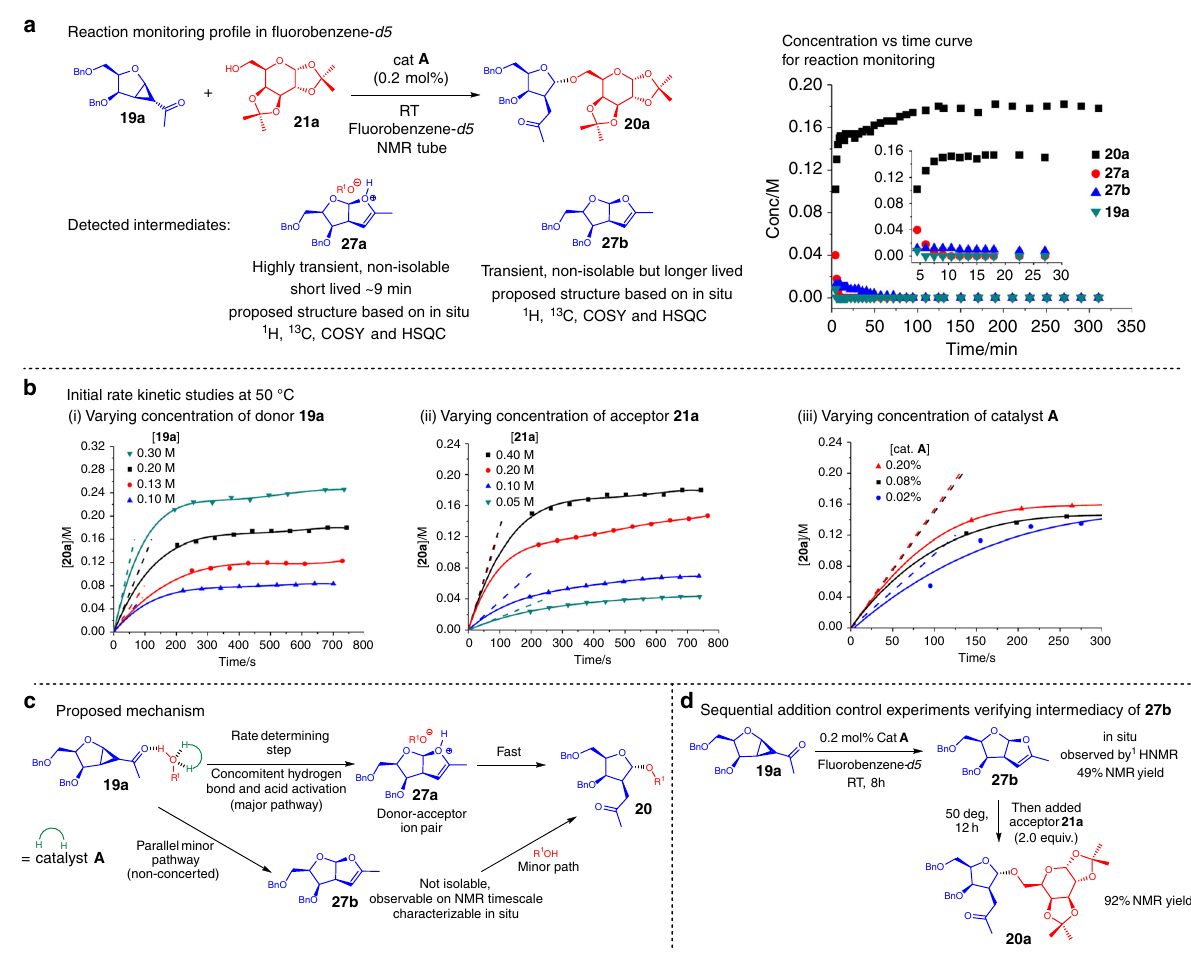
Fig. 2 Mechanistic and kinetic studies. a In-situ NMR monitoring of strain-release furanosylation of 19a at RT. b Initial rate kinetic studies of strain-release furanosylation. c Proposed mechanistic model of the strain-release furanosylation. d Sequential addition control experiments to verify